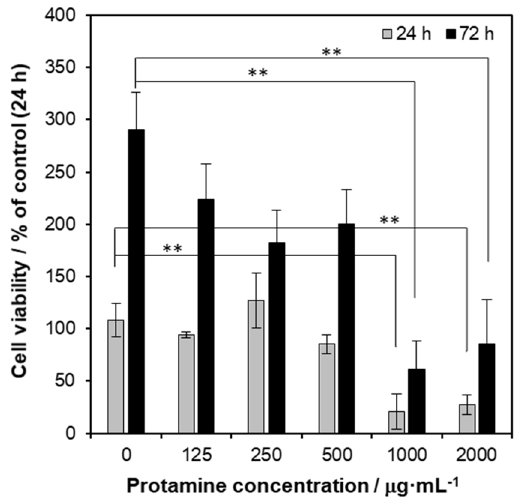
Figure 7. In vitro biocompatibility of protamine / HAp powder extracts to osteoblastic cells. MG-63 human osteoblastic cells were cultured in various concentrations of protamine / HAp powder extracts for 24 and 72 h. Cell viability was analyzed using ISO 10993-5:2009 “Tests for Cytotoxicity—In vitro Methods”.